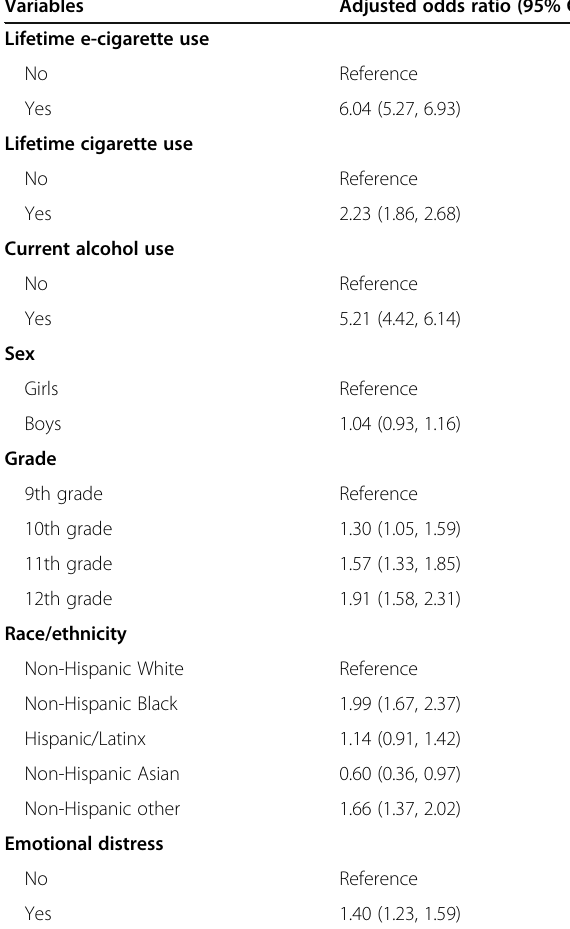
Table 2 Risk for current cannabis use